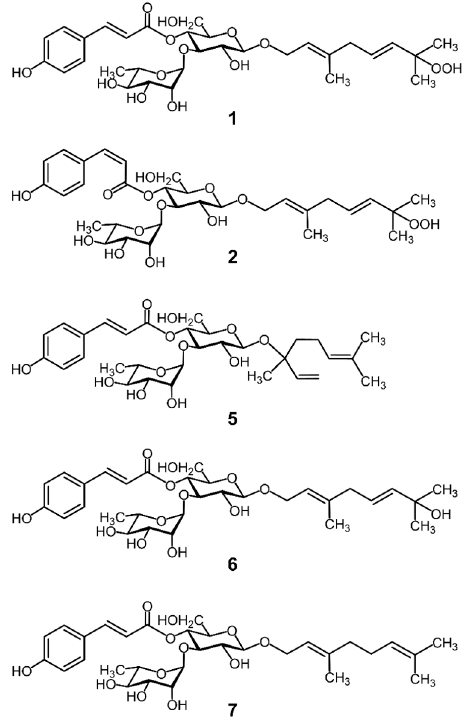
Figure 1. Structures of the known monoterpene glycosides; ( 1 ) liguroside A, ( 2 ) liguroside B, ( 5 ) lipedoside B-III, ( 6 ) kudingoside B, and ( 7 ) kudingoside A.